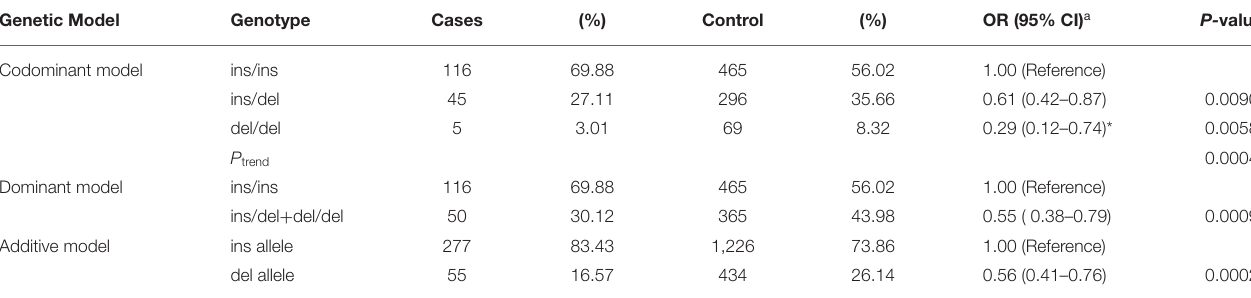
TABLE 2 | Associations between rs72014506 and sudden cardiac death susceptibility in case–control sets recruited during 2012–2019. Genetic